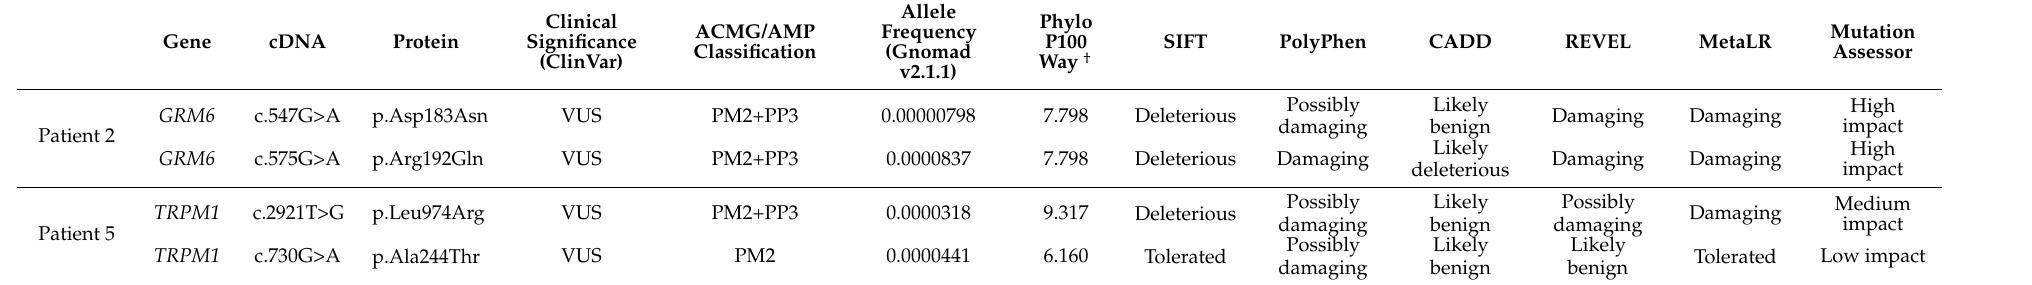
Table 4. Summary of the VUS variant details, minor allele frequency, and pathogenicity predictions.